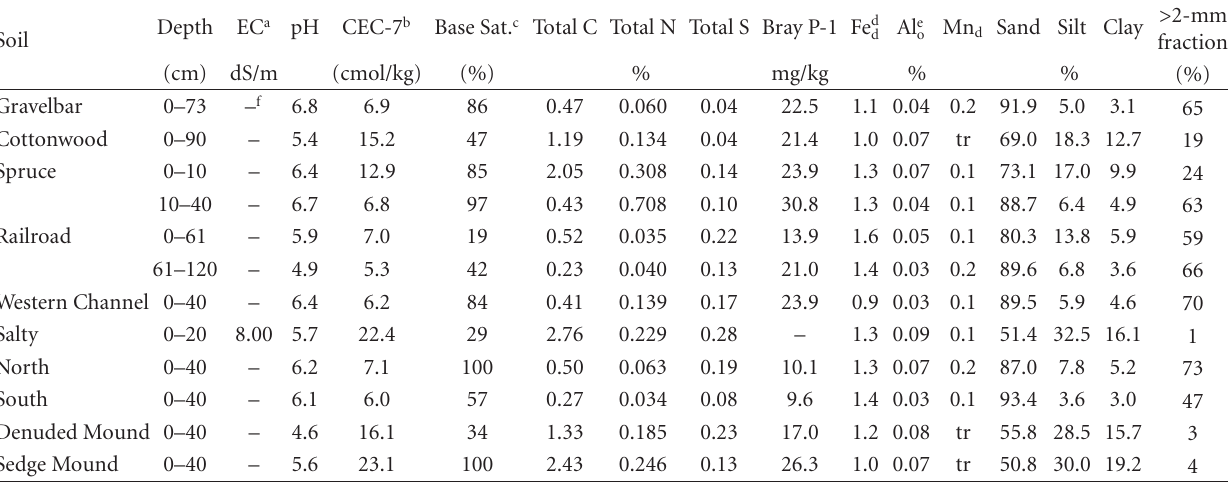
Table 6: Selected chemical and physical properties of study